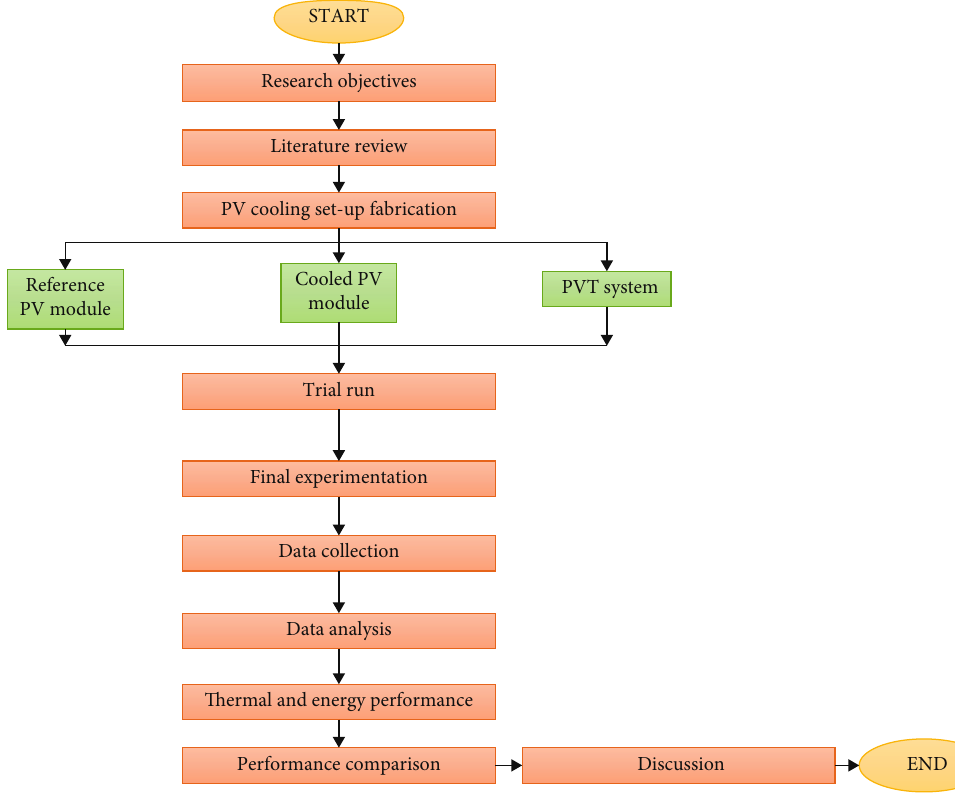
Figure 2: Flowchart highlighting the methodology of the